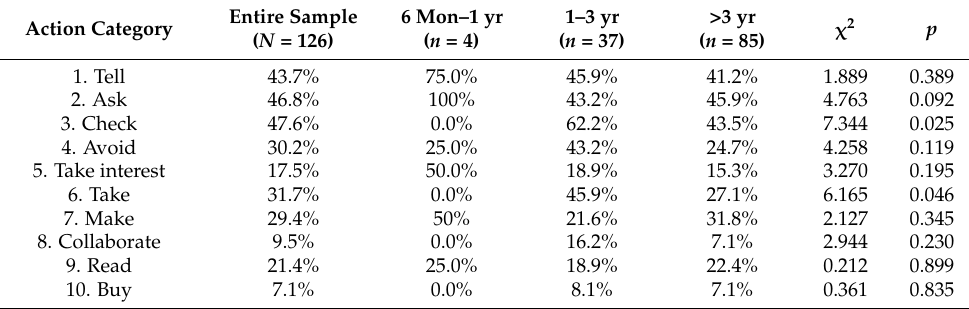
Table 3. Comparison of action category use between years since diagnosis. Action